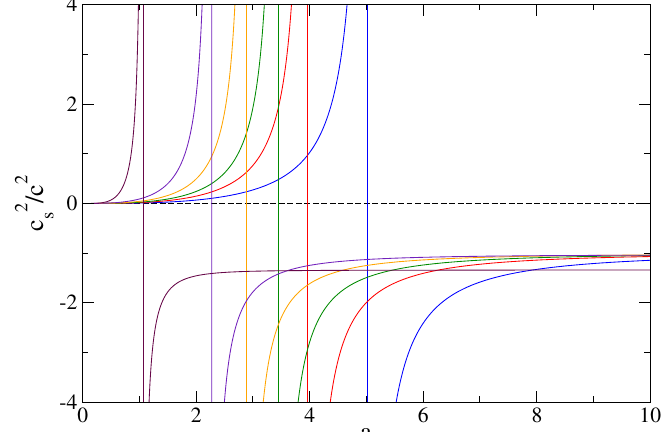
Figure 6. Normalized squared speed of sound c 2 s / c 2 as a function of the scale factor a for Ω m ,0 = 0.309, B = 3.53 × 10 − 3 and n = 0,1,2,3,5,10,100. It diverges and becomes negative when the Universe becomes